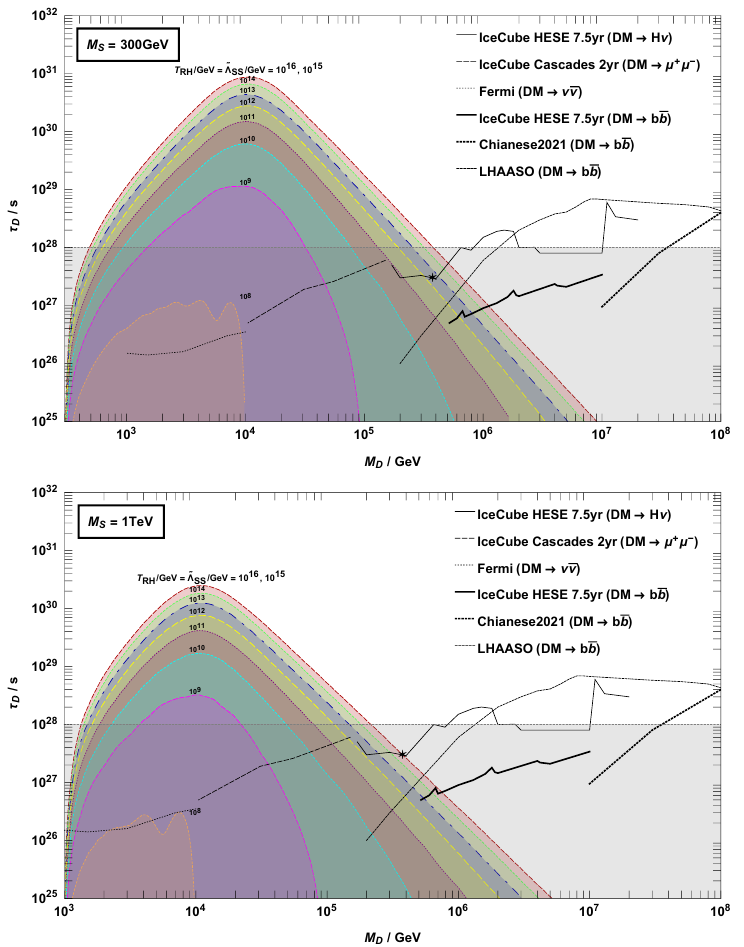
Figure 7 . Allowed regions in the lifetime versus mass plane for the indicated values of ˜Λ SS = T RH for M S = 300 GeV (top) and M S = 1 TeV